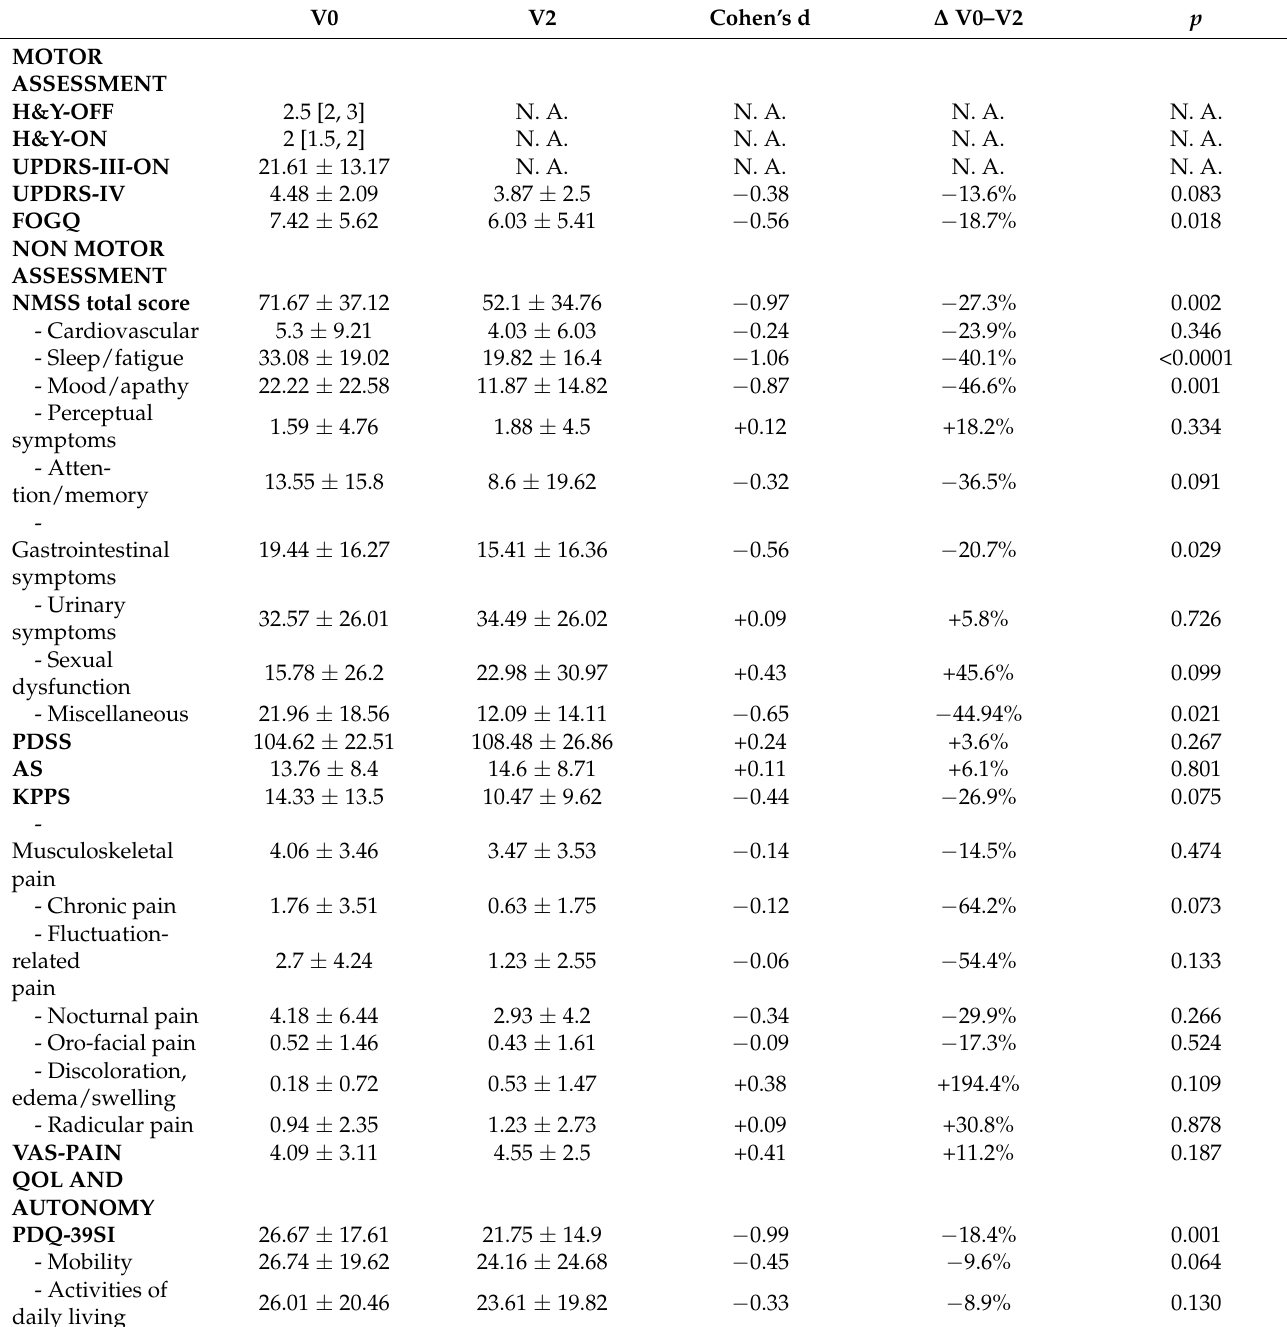
Table 2. Change in the score of the NMSS and other scales of the study from V0 (baseline; N = 33)